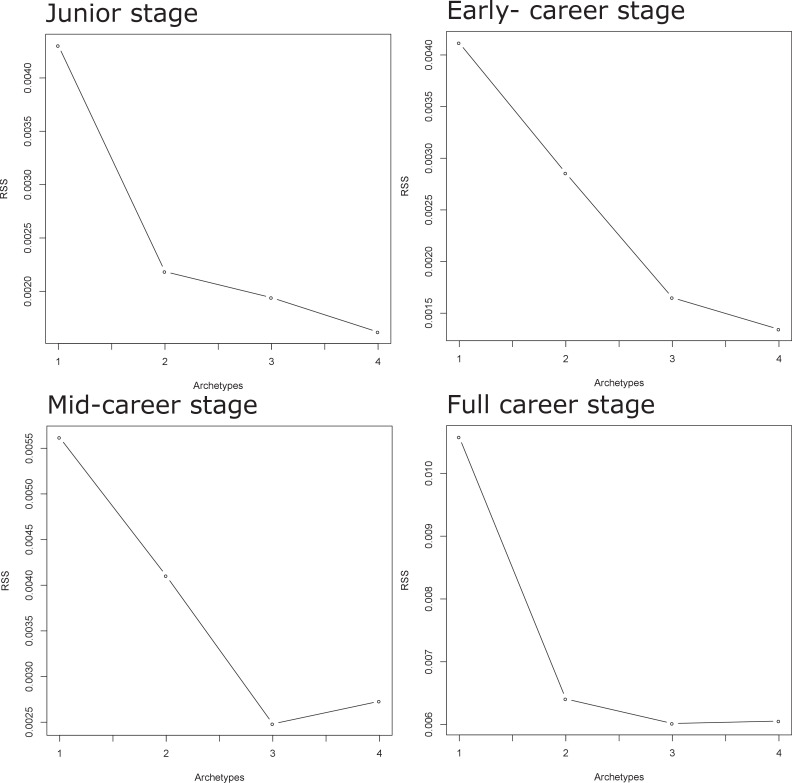
Screeplots of the residual sum squares (RSS) which allows determining the number of archetypes for each career stage.